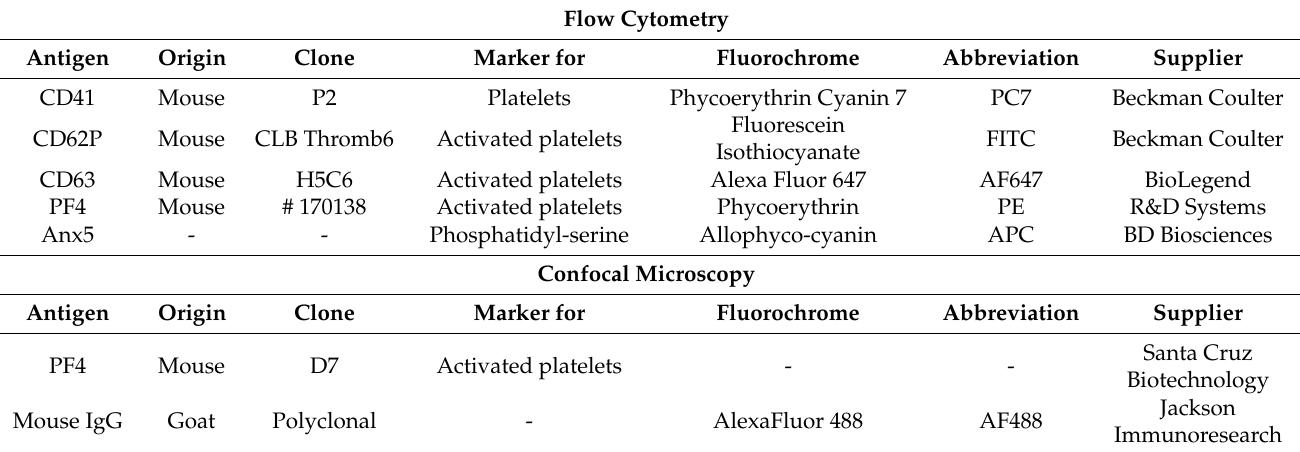
Table 2. Antibodies and fluorochrome conjugates used for flow cytometry and confocal microscopy. Flow